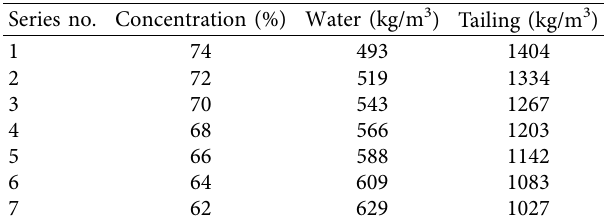
Table 3: Mix proportion of